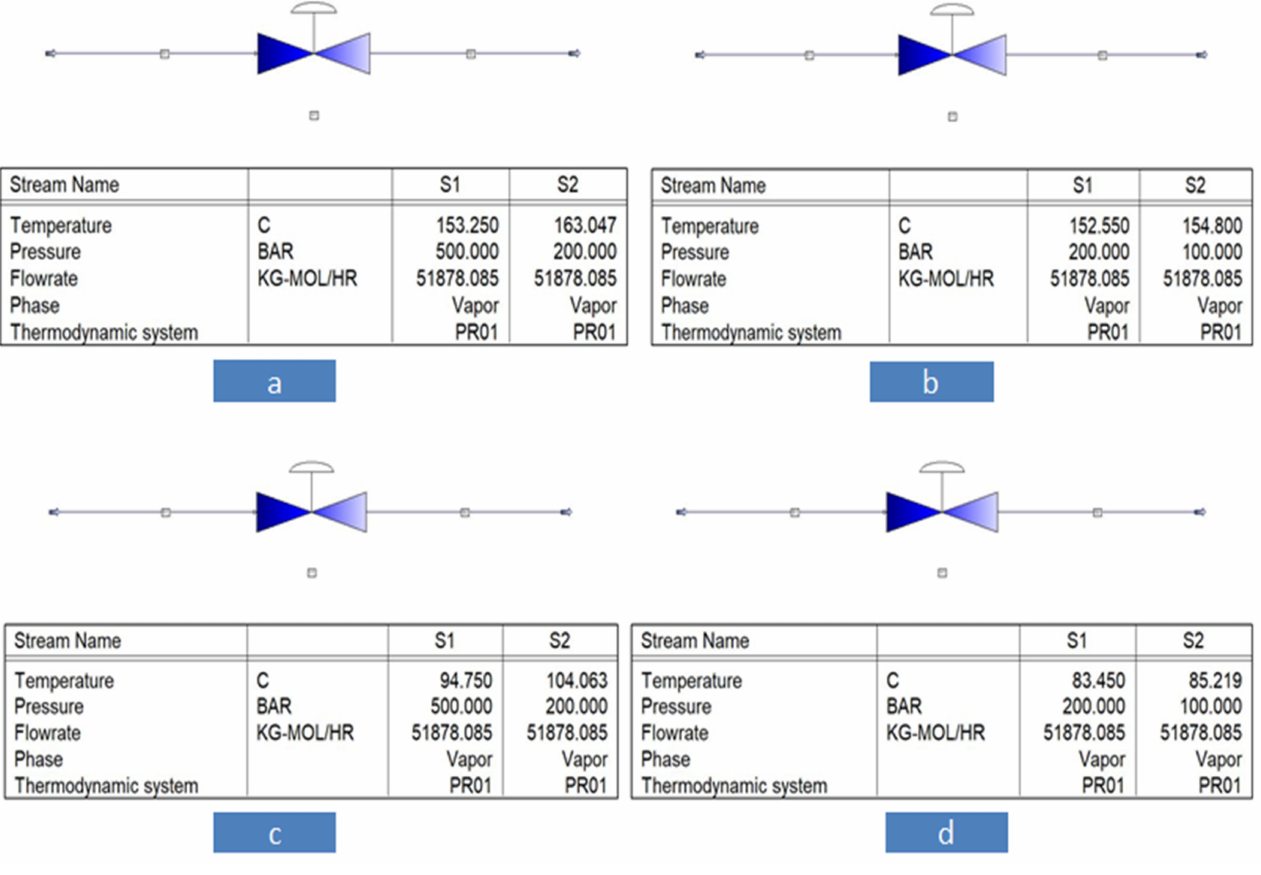
Figure 7. Pressure-reducing valve: ( a ) Pressure-reducing valve (2) in the first cycle, ( b ) Pressure- reducing valve (4) in the first cycle, ( c ) Pressure-reducing valve (2) in the second cycle, ( d ) Pressure- reducing valve (4) in the second cycle. Table 4. Temperature rise result of hydrogen passing the pressure-reducing valve for the